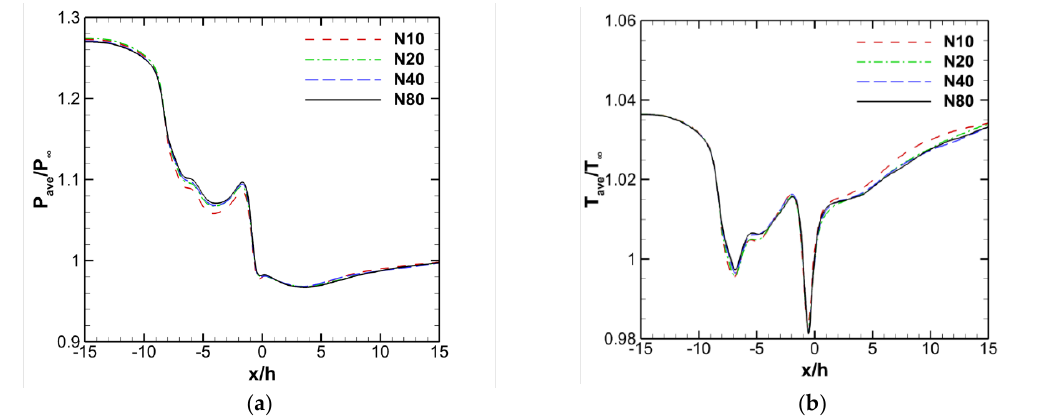
Figure 4. Time-averaged static-to-reference (a) pressure and ( b ) temperature ratio along the centerline.